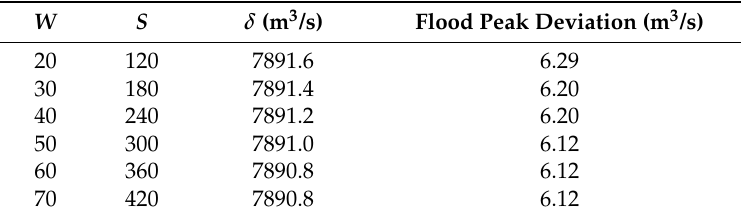
Table 4. Sensitivity analysis of distance judgment factor.